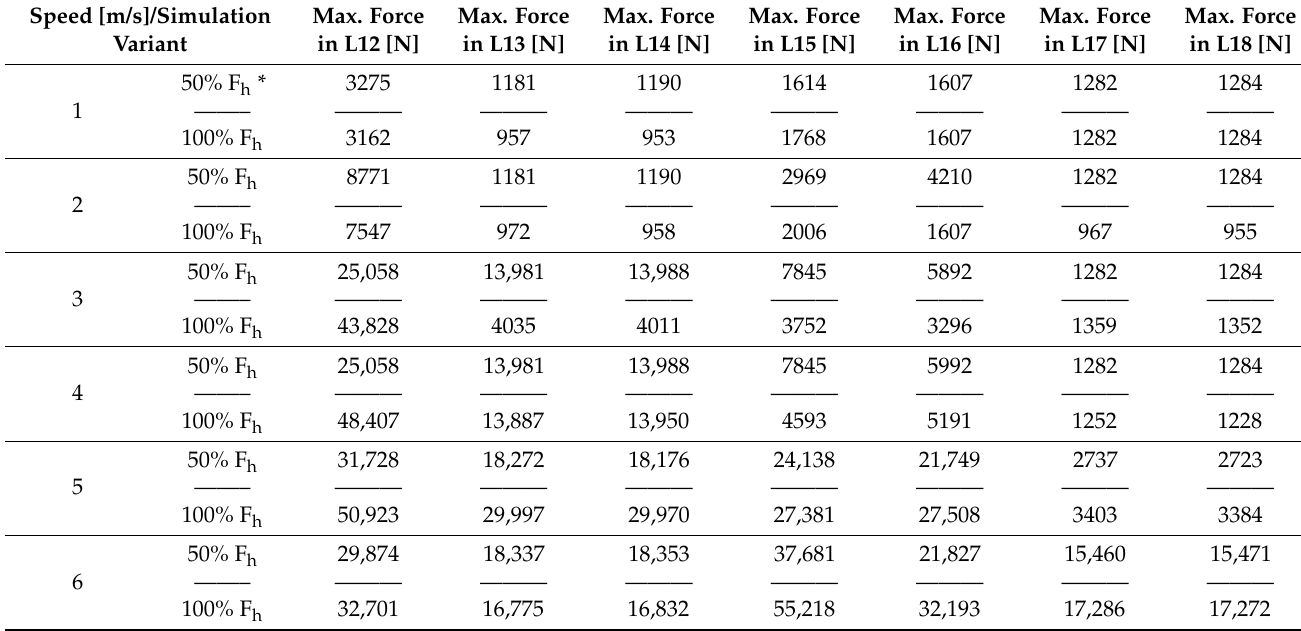
Table 3. Maximum forces in suspensions recorded during simulation of emergency braking at different travel speeds (suspensions L12-L18).